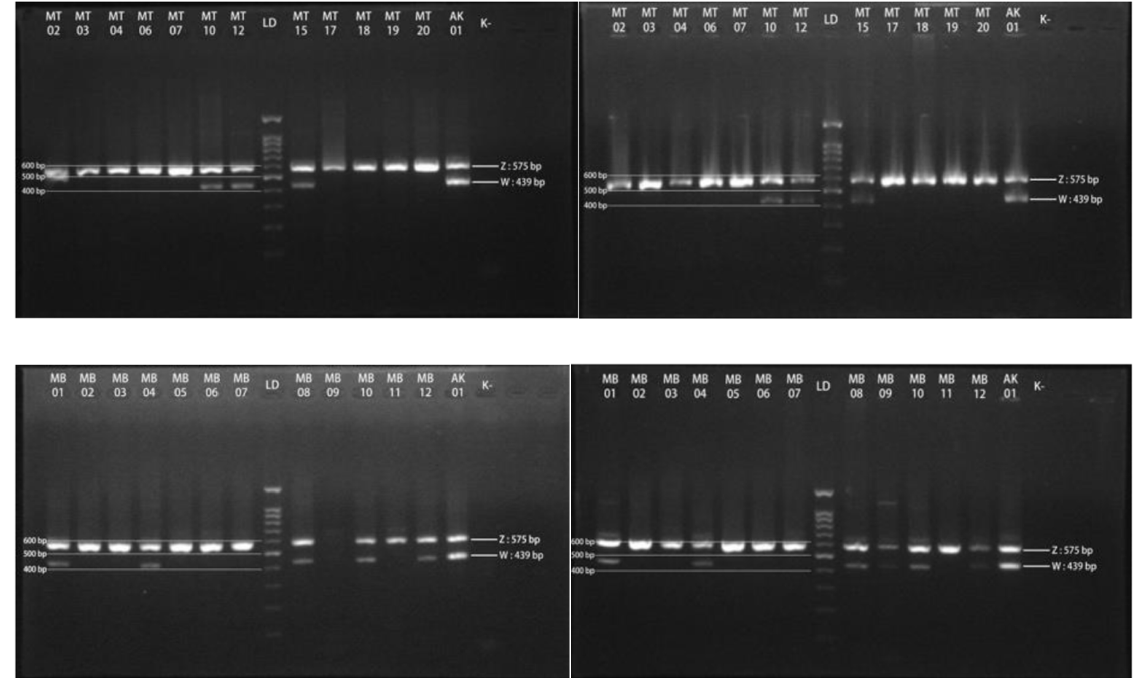
Figure 3. Gel visualizing of CHD-genes amplification of Maleo using extracted DNA (left) and Lysate (right) for molecular sexing of Tambun (above) and Tanjung Binerean (below) samples. AK1, positive control, female chicken; K, negative control, no template.